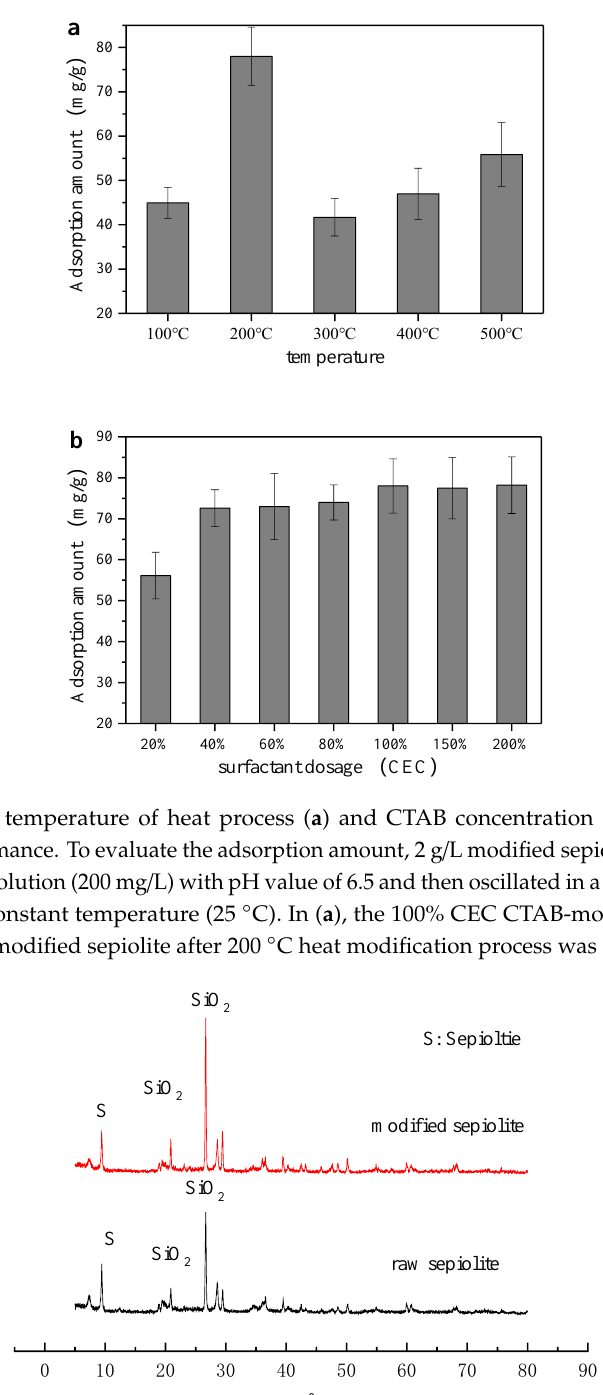
Figure 3. SEM image of original sepiolite ( a ) and modified sepiolite ( b ) in the literature [2]. 3.2. Effect of the Operation Condition on Adsorption Performance In spite of a much higher adsorption capacity obtained through the organic modification, the adsorption performance of anionic dye was also restricted by many factors, such as pH, adsorbent dosage and adsorption duration[38]. As can be seen from Figure 4a,b, the pH value of the solution had a great influence on the adsorption effect, especially with higher adsorbate concentration. When the initial concentration reached 200 mg/L, the adsorption amount declined from 93.78 to 64.2 mg/g with the increase in pH. Since the positively charged adsorption site of the adsorbent surface increased under acidic conditions, the electrostatic attraction to the negatively charged anionic dye could be improved. The positive charge on the adsorbent surface reduced with the pH increase and gradually exhibited a negative charge, which could lead to repulsion between the adsorbent and the anionic dye. Figure 4c,d show that the decolorization rate of organically modified sepiolite to Acid Orange II increased rapidly, but the adsorption amount decreased when the dosage increased from 0.5 to 5 g/L. When the dosage of adsorbent was fixed, the modified sepiolite had a large amount of superfluous silicic hydroxyl groups and obvious pore effects with a small amount of Acid Orange II. However, when the Acid Orange II was excessive, the sepiolite quickly reached saturation and the surface free energy gradually decreased. Adsorption duration is an important factor in studying adsorption performance and kinetics. As shown in Figure 4e,f, the entire adsorption process can be divided into two phases. In the first 60 min, the Acid Orange II is rapidly adsorbed, and over 90% of the Acid Orange II is adsorbed after 300 min.